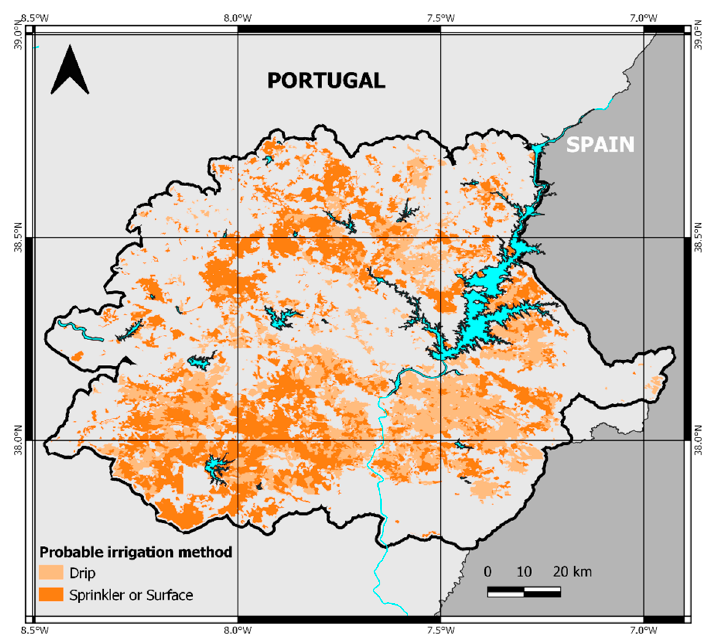
Figure 5. Most likely irrigation method in the potentially irrigated study area.